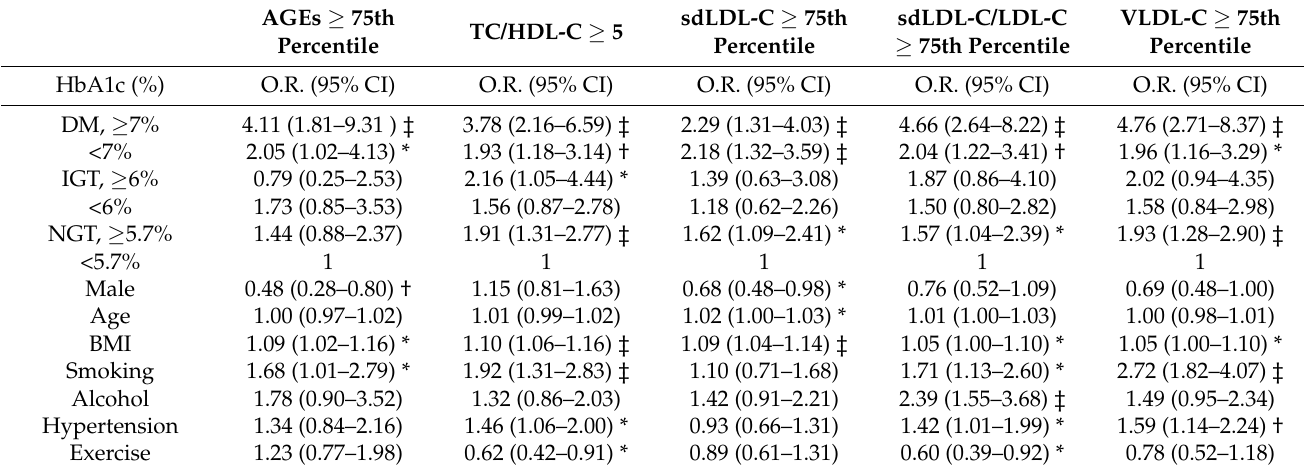
Table 5. Multivariate logistic regression model for the odds ratio of atherogenic dyslipidemia in all